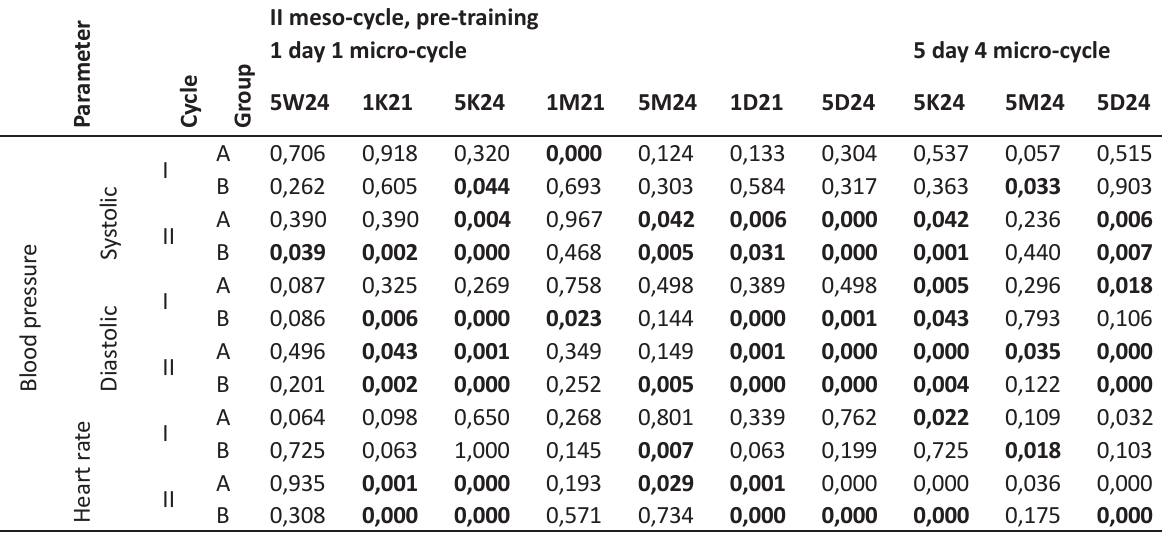
Table 2. Evaluation of means of blood pressure and heart rate in selected days of training during Cycle I and II – second meso-cycle pre-training measurements – variance analysis and